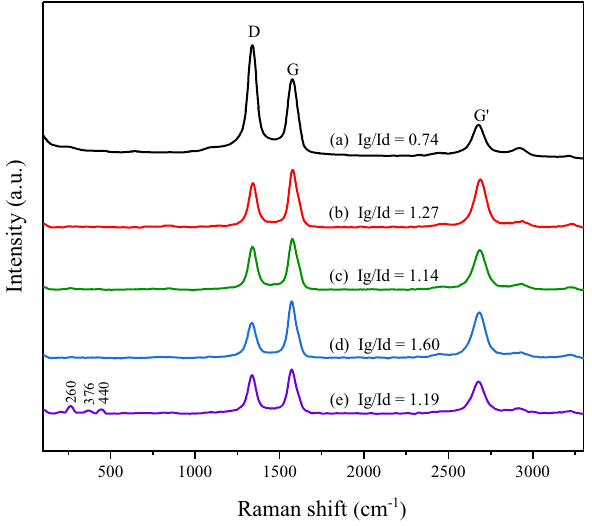
Figure 6. Raman spectra of the CNTs synthesized over different catalysts at 800 °C for 3 h: ( a ) CNTs_ commercial (Bayer ® ), ( b ) CNTs_NiMo, ( c ) CNTs_CoNiMo, ( d ) CNTs_FeNiMo, and (e) CNTs_CoFeMo.